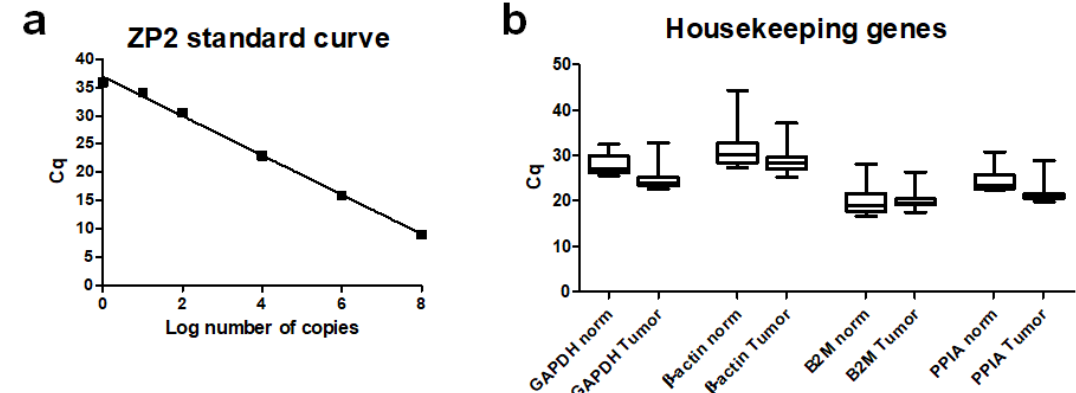
Figure 1. Optimization for qPCR to reliably detect low expression of ZP2. ( a ) Standard curve for ZP2 expression using dilution series with known copy numbers of ZP2-carrying vector molecules. E = 94%; R 2 = 0.997; slope = − 3.48. ( b ) Ct values of housekeeping genes from normal and tumor tissue samples. B2M shows nearly identical expression levels in both tissues.